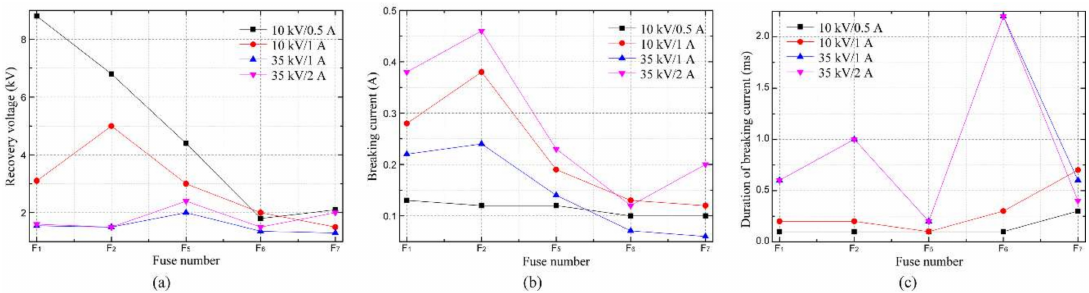
Figure 12. Breaking characteristic of each fuse type. ( a ) Amplitude of recovery voltage; ( b ) amplitude of breaking current; ( c ) duration of breaking current.